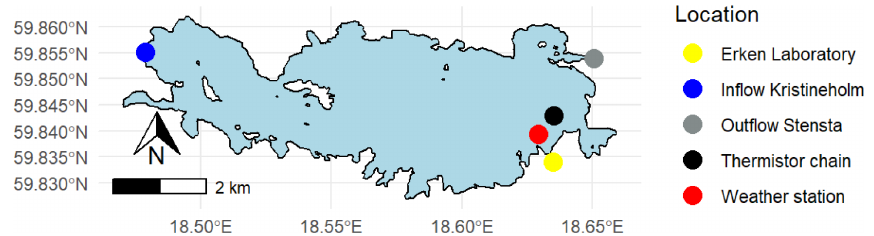
Figure 1. Map of Lake Erken. The locations of the monitoring systems are shown.